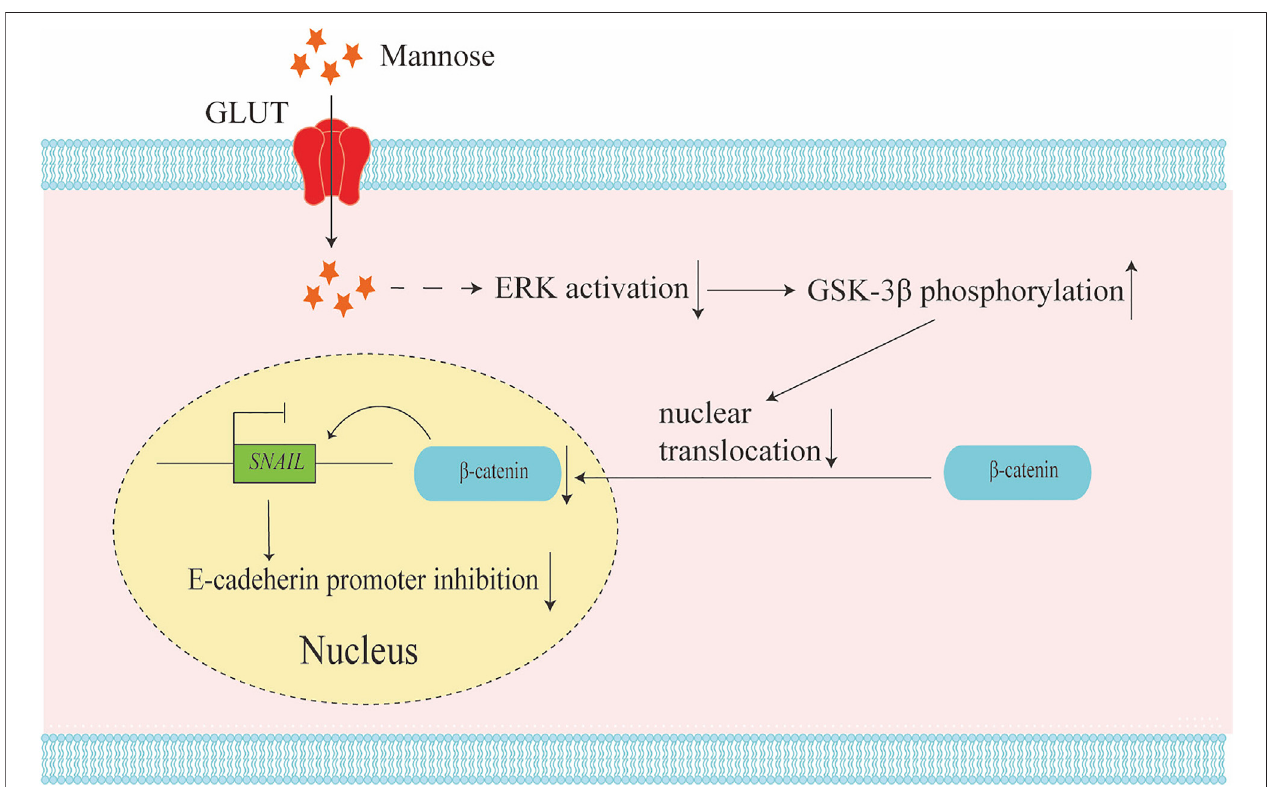
FIGURE2| Mannoseinhibitstumormetastasis byrelievingepithelial-mesenchymaltransition(EMT).MannosecouldreducetheactivationoftheERKpathwayand increase the phosphorylation of GSK-3 β . The phosphorylation of GSK-3 β will reduce the phosphorylation level of tyrosine 654 at β -catenin and inhibit the nuclear translocation of β -catenin. The reduction of β -catenin in the nuclear down-regulates SNAIL expression, and the down regulation of SNAIL could promote E-cadherin expression. This regulatory mechanism results in the inhibition of tumor EMT.